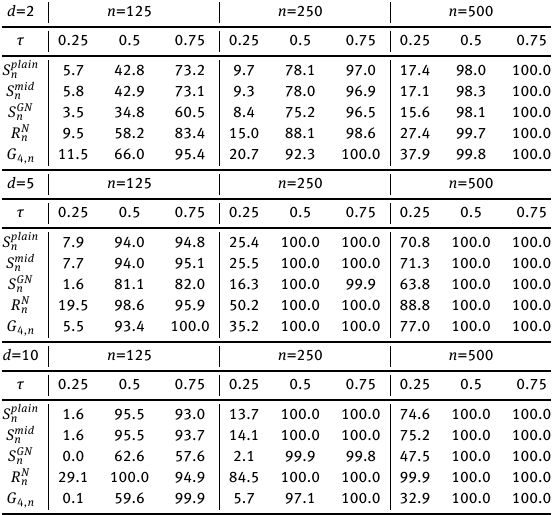
Table 3: Percentages of rejection at 5% significance level, as estimated from 1000 replicates, for the tests based on S plain n , S mid n , S GN n , R N n and G 4, n under the χ 2 copula (*Kendall’ τ refers to the associated normal copula).